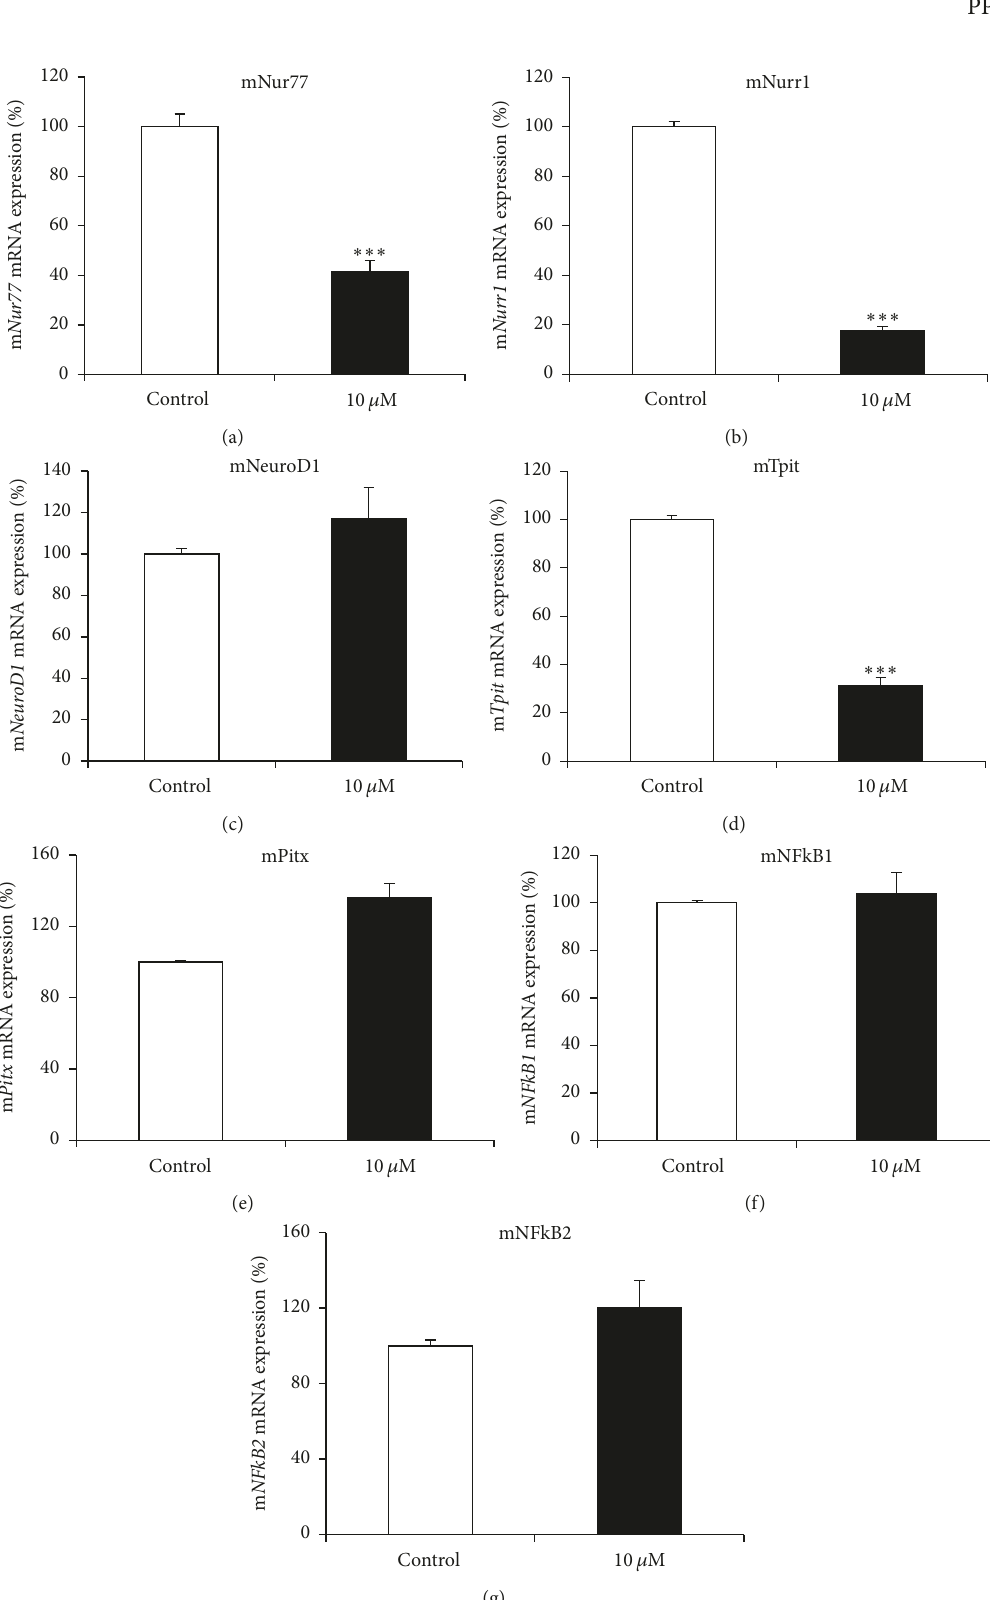
Figure 7: MEKT1-mediated effects on the mRNA expression of mouse Nur77 , Nurr1 , NeuroD1 , Tpit , Pitx , NFkB1 , and NFkB2 in AtT20 cells. AtT20 cells treated with MEKT1 (10 𝜇 M) or 0.1% DMSO (vehicle control) for 24 hours. (a) Nur77 mRNA expression, (b) Nurr1 mRNA expression, (c) NeuroD1 mRNA expression, (d) Tpit mRNA expression, (e) Pitx mRNA expression, (f) NF 𝜅 B1 mRNA expression, and (g) NF 𝜅 B2 mRNA expression. Data are expressed as percentages (100%) of control. Data represent mean ± SEM ( 𝑛 = 4 ). ∗∗∗ 𝑃 < 0.001 versus